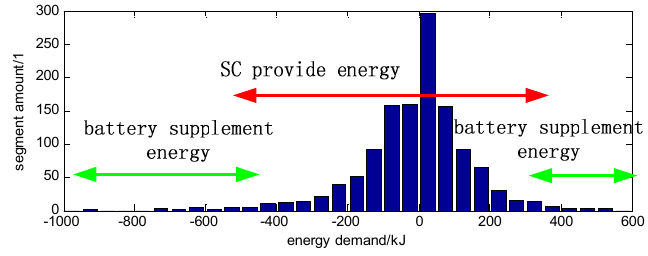
Figure 19. Power distribution of the battery/SC HESS.